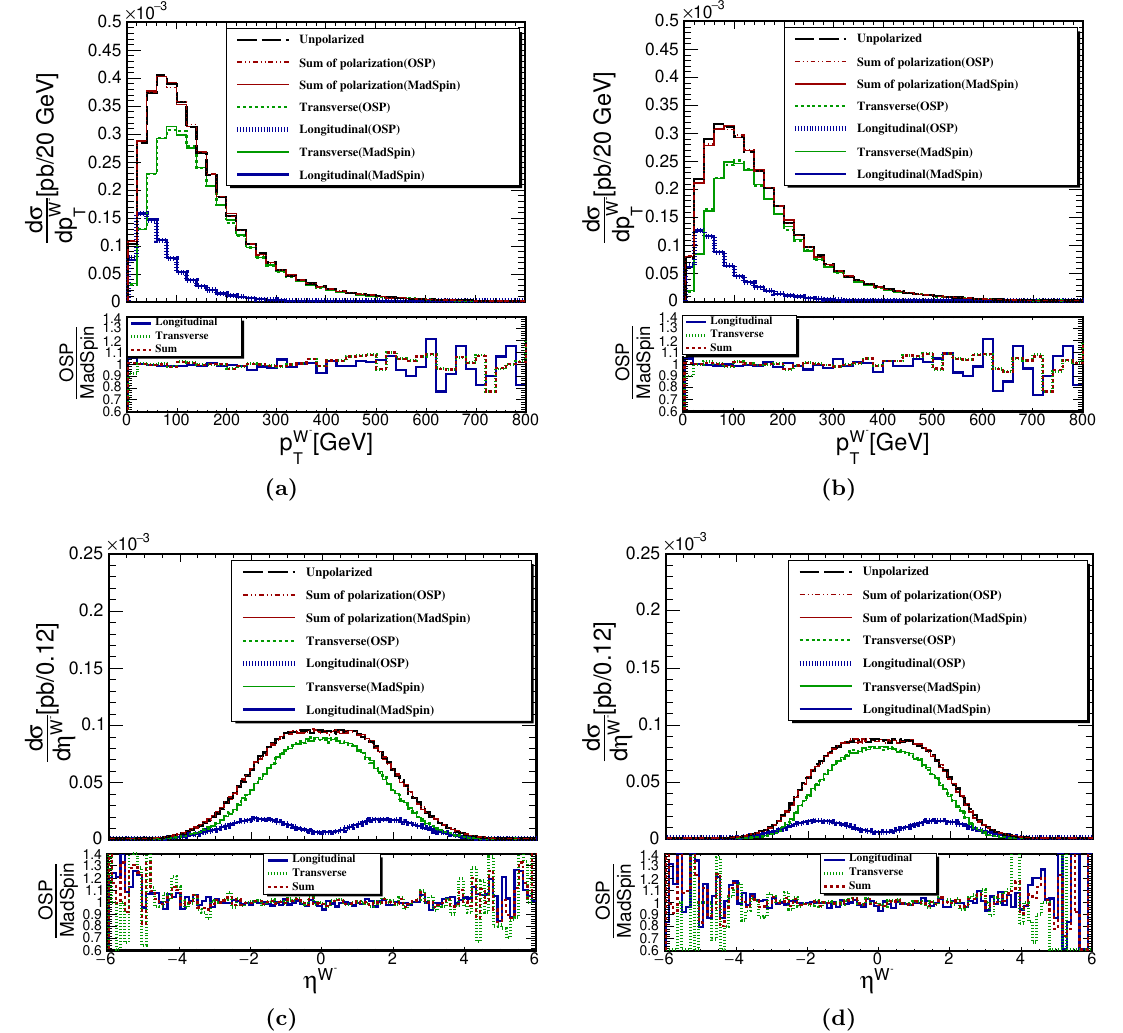
Figure 6. Same as (cid:12)gure 4 but for (a,b) p T ( W (cid:0) ) and (c,d) (cid:17) ( W (cid:0) ).